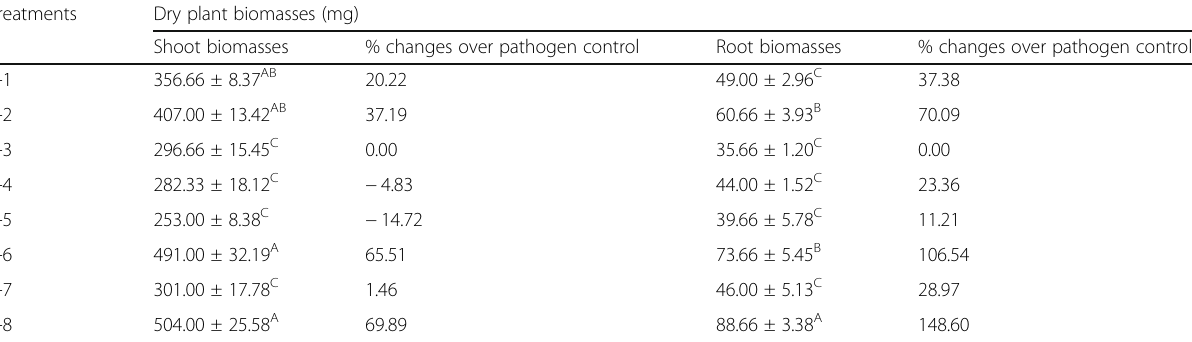
Table 4 Effect of seed application with effective chitinolytic bacteria on dry biomasses of pigeon pea plants under pathogen pre- challenged conditions